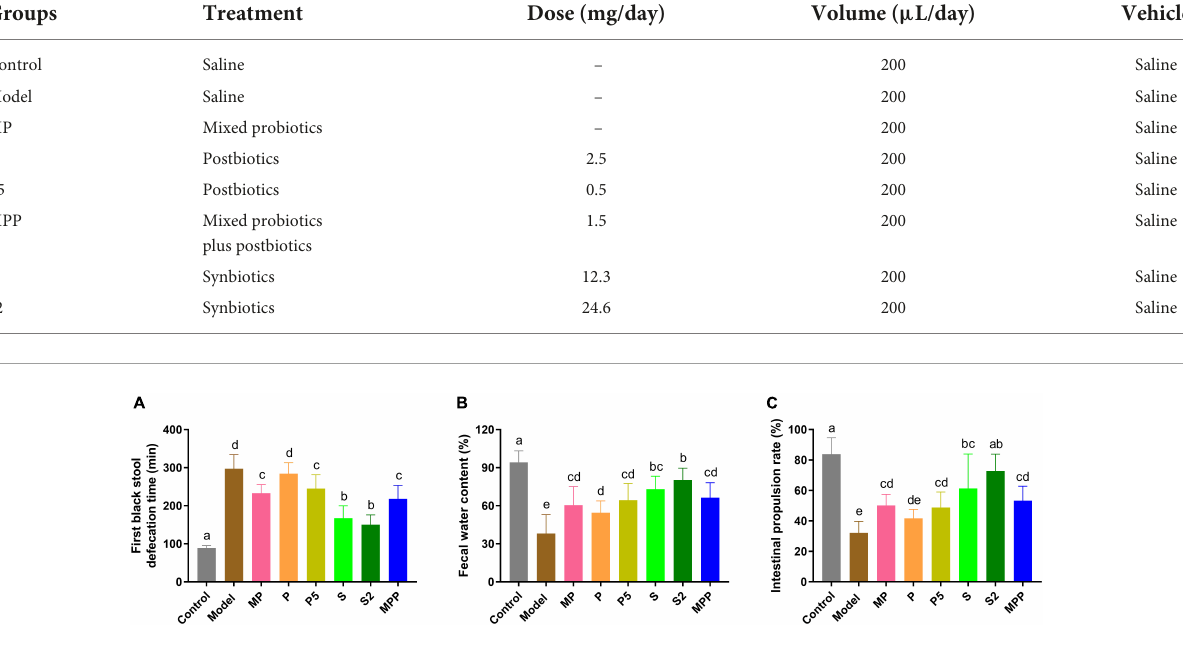
FIGURE1 The differences in (A) time to the first black stool, (B) fecal water content, and (C) intestinal propulsion rate among groups. Values are expressed as mean ± SEM ( n = 8). Results were compared by one-way ANOVA followed Duncan’s multiple comparison test. Different letters represent significant differences ( p < 0.05).